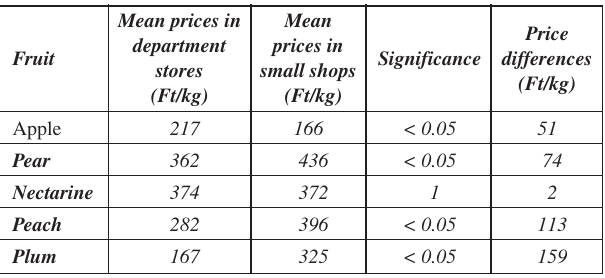
Table 1. Comparison of the mean prices of fruits sold in different types of